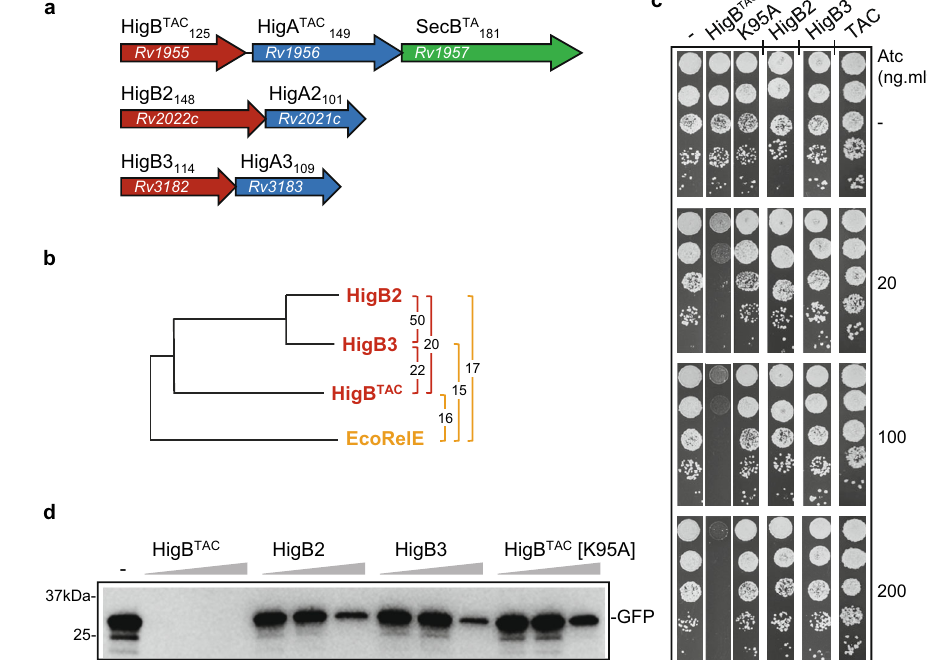
Fig. 1 Impact of HigB toxins on growth and protein synthesis. a Schematic representation of the three HigBA-like systems of M. tuberculosis . Toxins are shown in red, antitoxins in blue and the chaperone of the TAC system (SecB TA ) in green. The amino acid length of each protein is given as a subscript and the locus tag for each gene within color arrows. b Phylogenetic tree of M. tuberculosis HigB toxins (red) and E. coli RelE (orange). The percentage of sequence identity between pairs of toxins is shown on the right (colored brackets). c Expression of HigB toxins in vivo. M. smegmatis transformed with pGMC-vector (-), HigB TAC , HigB TAC [K95A], HigB2 or HigB3 or TAC (HigB/HigA/SecB) TAC were serial diluted and spotted on LB agar plates supplemented with or without Atc inducer at the indicated concentration. Plates were incubated for 3 days at 37 °C. d In vitro transcription/translation reactions assessing the synthesis of GFP protein in the absence (-) or presence of increasing concentrations of HigB toxins, (0.3, 3, and 6 µ M). Samples were separated by SDS-PAGE and revealed by western blot using an anti-GFP antibody. Representative results of three independent experiments are